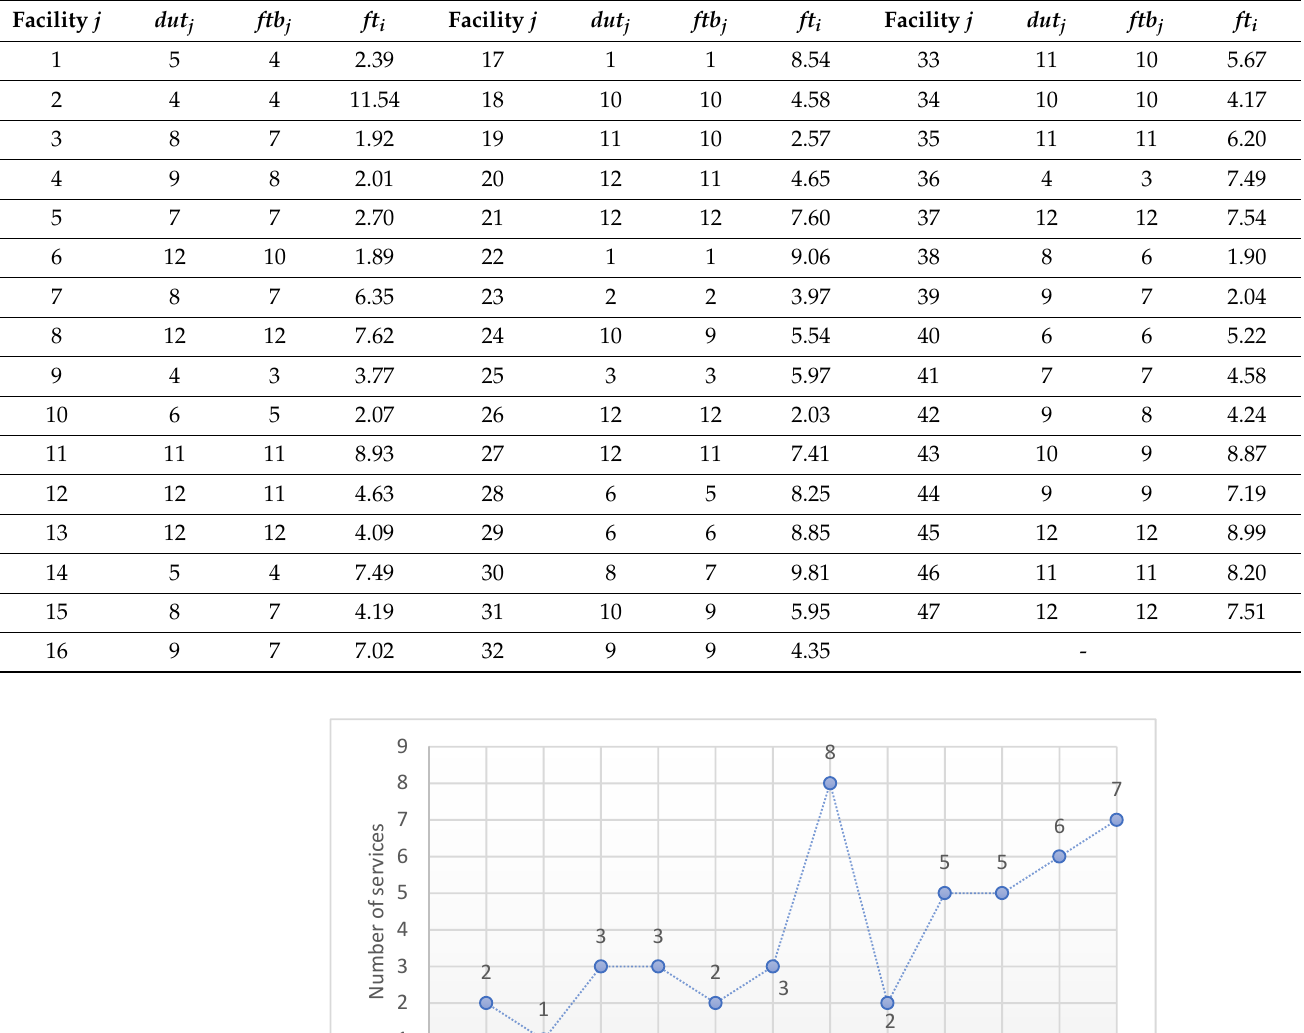
Table 13. The finished times for facility services.